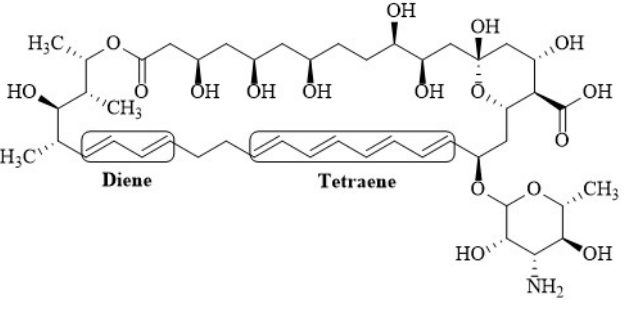
Figure 2. Structure of Nystatin 2 .